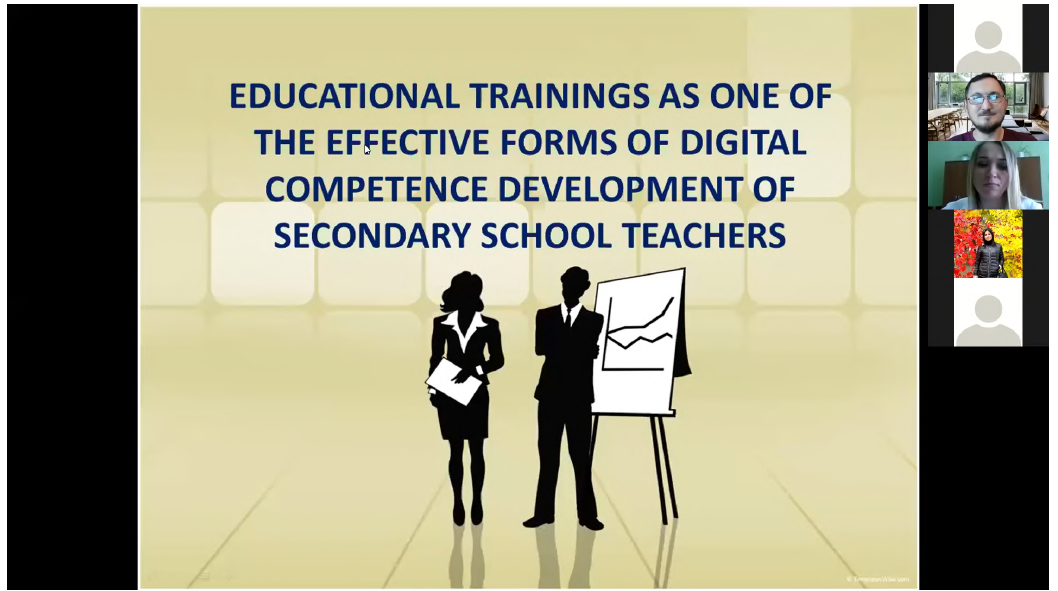
Figure 38: Presentation of paper